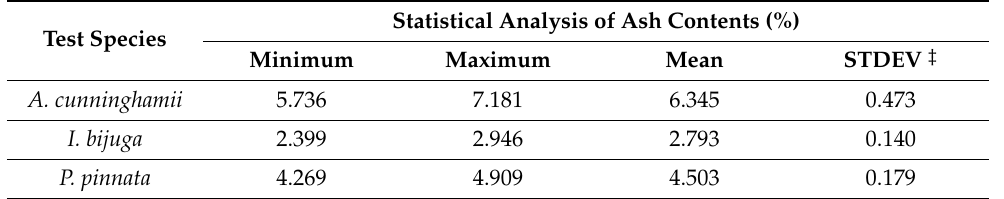
Table 7. ANOVA of ash content of sawdust pellets of test species. Sum of Square df Mean Square F Sig. Between group 94.619 2 Within group 3.815 Total 98.433